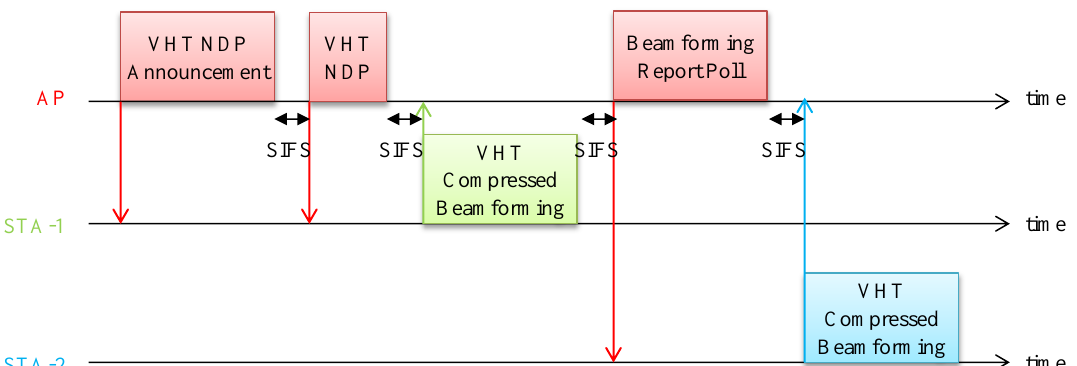
Figure 1. VHT sounding protocol specified by IEEE 802.11ac.